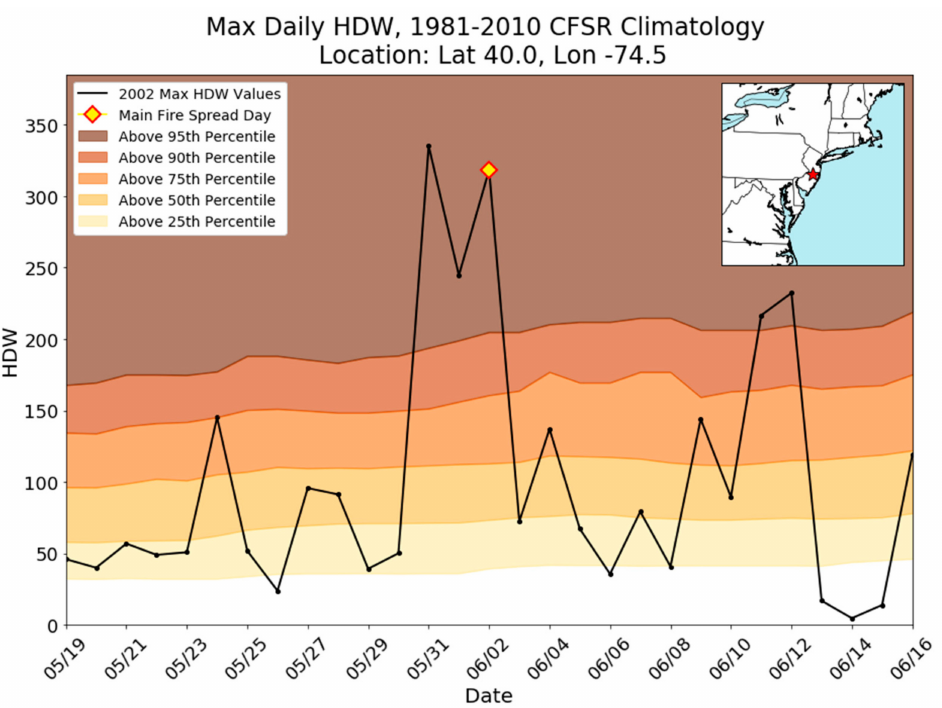
Figure 6. As in Figure 4, but for the Double Trouble Fire (grid point 40.0 ◦ N, 74.5 ◦ W; 29-day period centered on 2 June). The black trace represents HDW values calculated from CFSR for the same 29-day period in